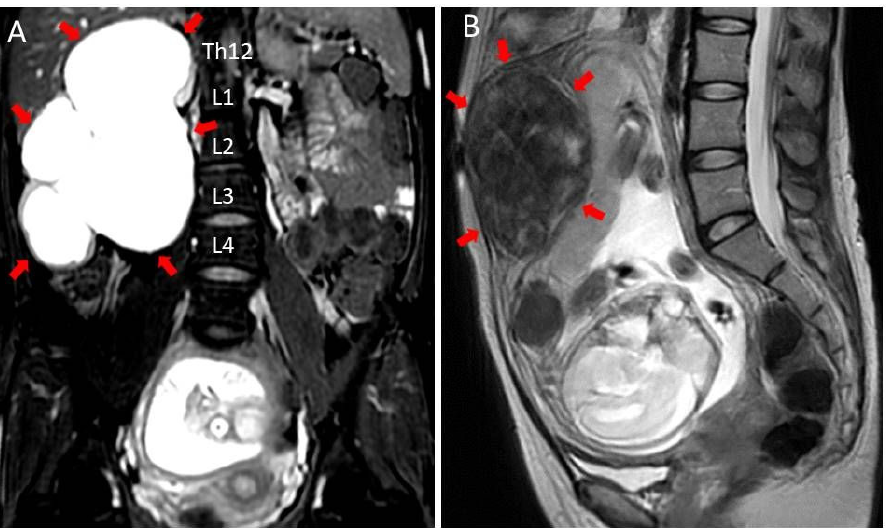
Figure 1. Magnetic resonance imaging shows a thin and multilocular right kidney measuring 15 cm × 12 cm in size (red arrows), approximately the height of five vertebral bodies. ( A ) coronal view. Uterine fibroids with partial degeneration (10 cm × 5 cm/red arrows) were found in the anterior uterine wall ( B ) sagittal view.